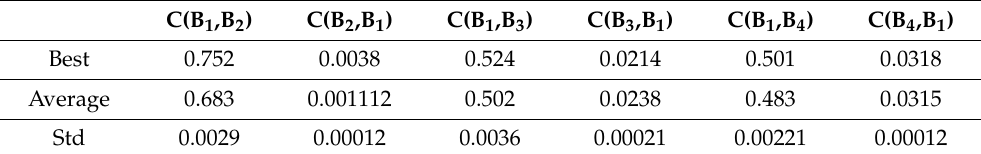
Table 11. Comparison of algorithms based on C-metric criteria.